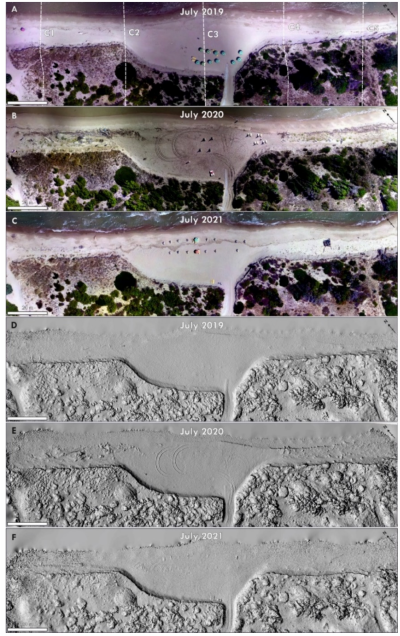
Figure 7. Orthophotos and DEM hillshades produced with the data acquired during the UAV flights in 2019 ( A , D ), 2020 ( B , E ), and 2021 ( C , F ) along Campomarino beach. (A) shows the locations of beach profiles C1–C5 extracted from the